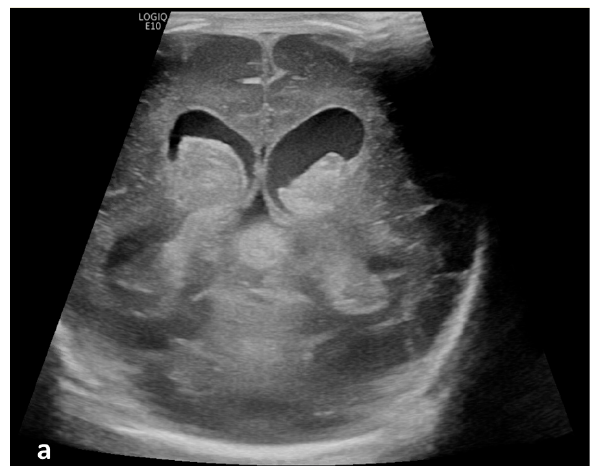
Figure 1. Cerebrospinal fluid (CSF) flow visualized in the ventricular system. A 15-day-old term girl with a history of bilateral grade III intraventricular hemorrhage and hydrocephalus underwent brain ultrasound. This patient also had cardiovascular comorbidities, including dextro-transposi- tion of great arteries, ventricular septal defect, and tricuspid regurgitation. ( a – c ) Sagittal B-Flow demonstrates turbulent caudocranial CSF flow in the cerebral aqueduct (arrows). The entire clip is presented in Table 2. provided as Supplemental Material 1.